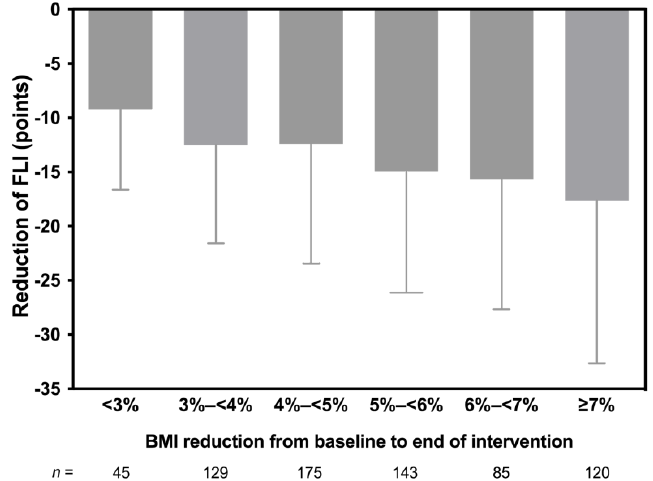
Figure 4. Reduction of FLI in relation to percent changes in body mass index (BMI).